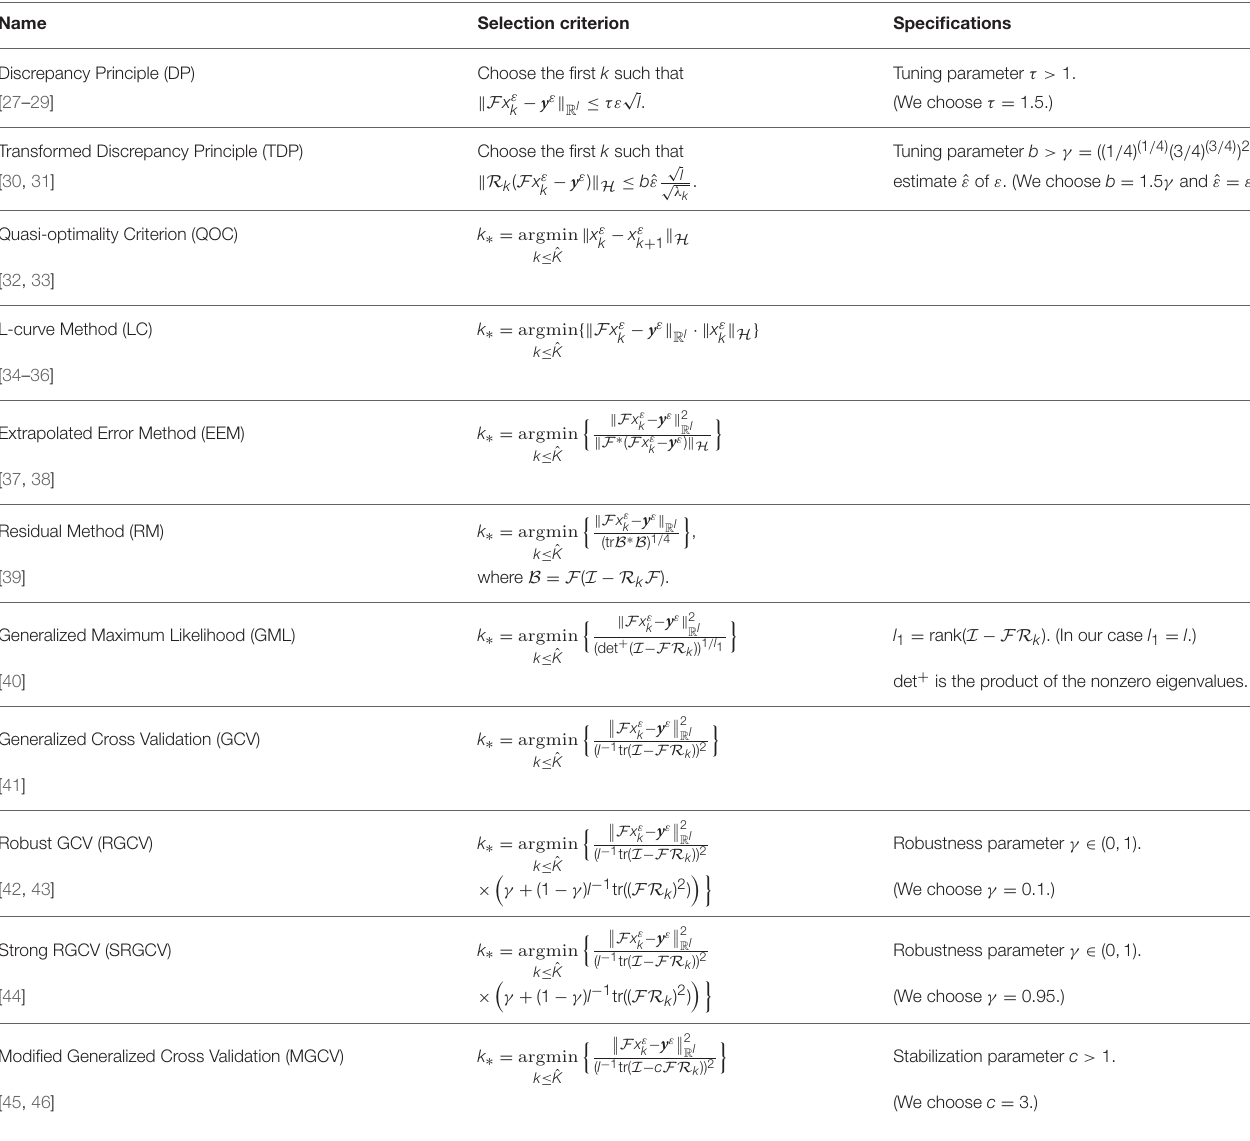
TABLE 1 | The parameter choice methods and their